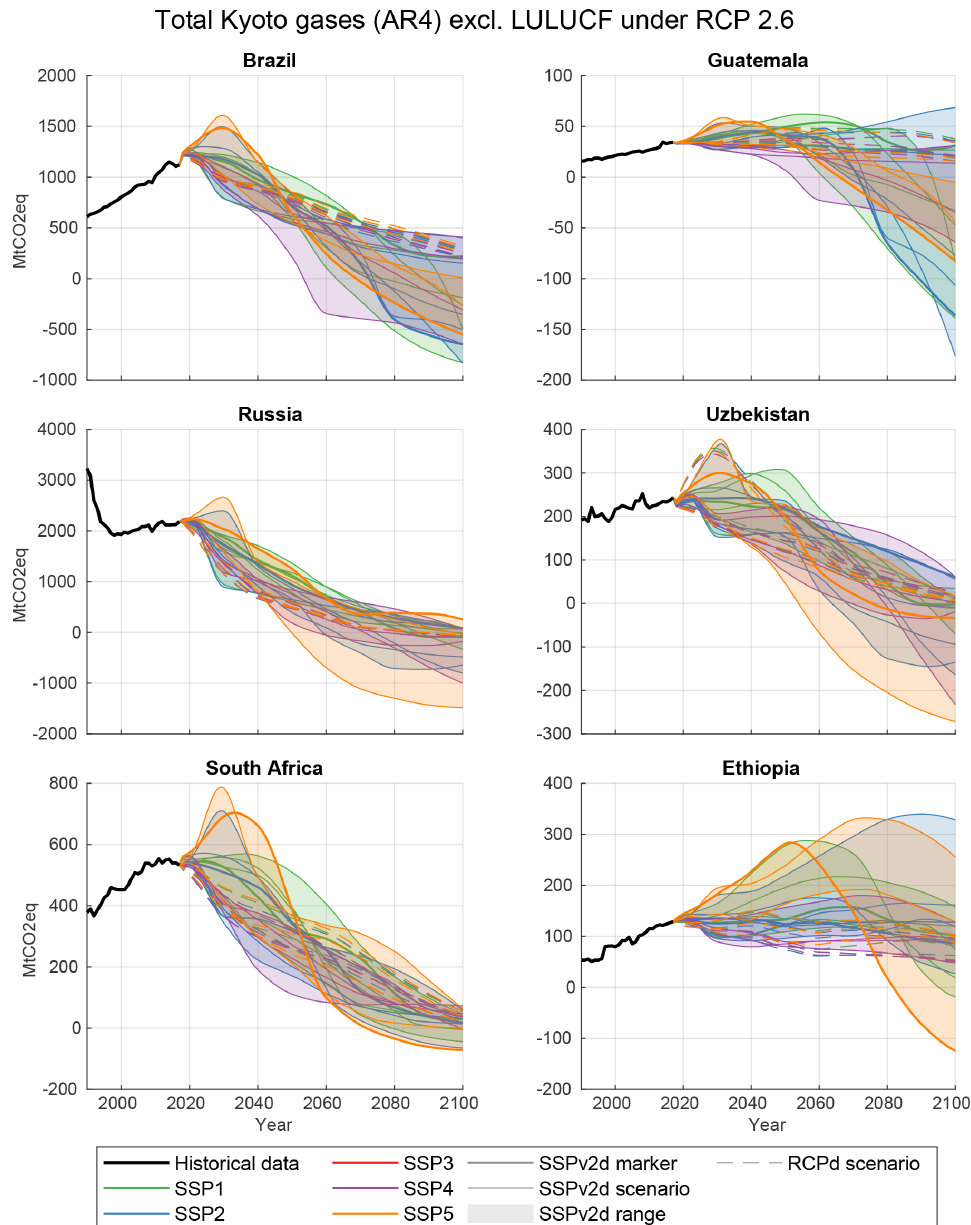
Figure 9. Results for RCP2.6 and all SSPs for both the RCPd and SSPv2d scenarios. Countries from the regions of Latin America, reforming economies, and the Middle East and Africa. All regions show strong influences of the diverse GDP growth projections (Fig. 7) within the